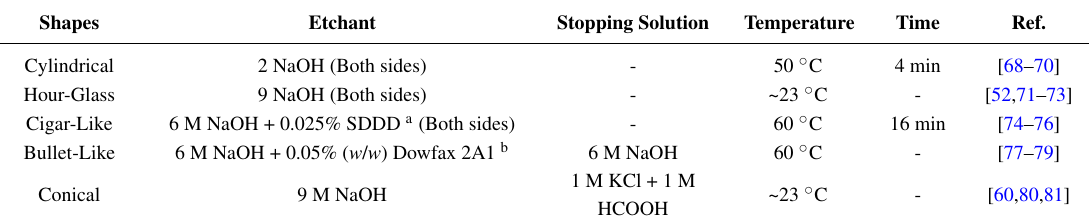
Figure 3. Artificial symmetric and asymmetric 1D nanochannels. Reprinted with permission from reference [67]. Copyright 2012 John Wiley and Sons. Table 2. Conditions for obtaining nanochannels (PET) in shapes.